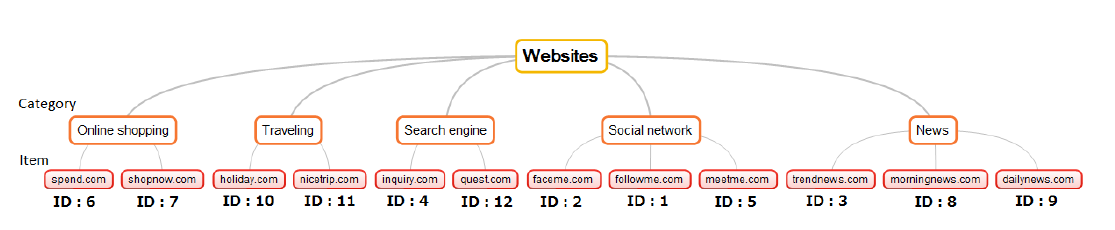
Figure 1. Website